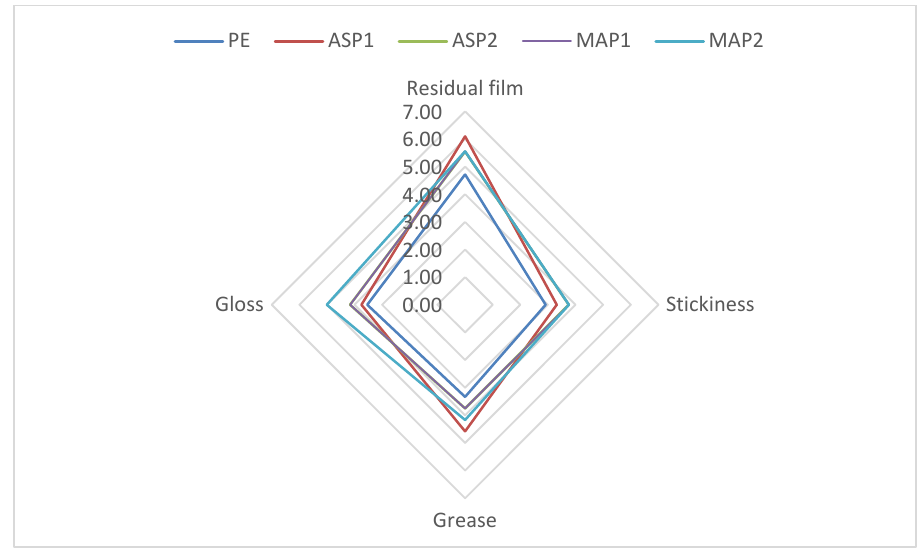
Figure 8. The results of sensory analysis of the investigated samples after application. Table 5. The results of sensory analysis of the investigated samples before application converted to 1–10 scale.